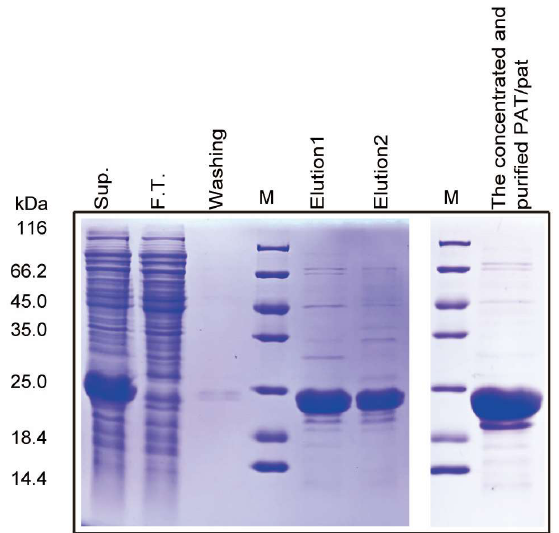
Figure 1. Purification of the overexpressed PAT/pat protein. Sup., Supernatant of Cell lysate. F.T., Flowthrough after Ni-resin binding. Flowthrough after Ni-resin